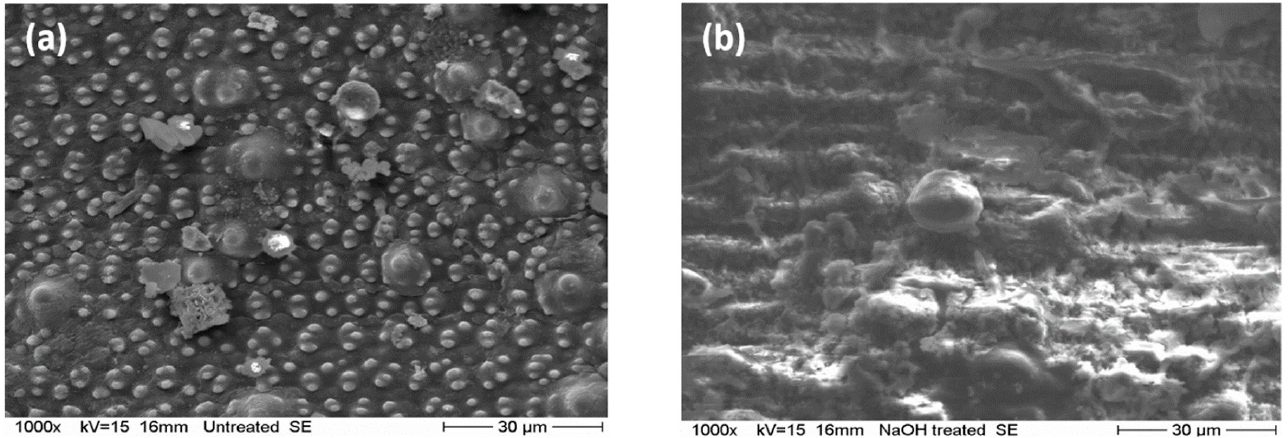
Figure 2. SEM micrographs of rice straw fiber surface of: ( a ) untreated fiber; ( b ) NaOH-treated fiber.